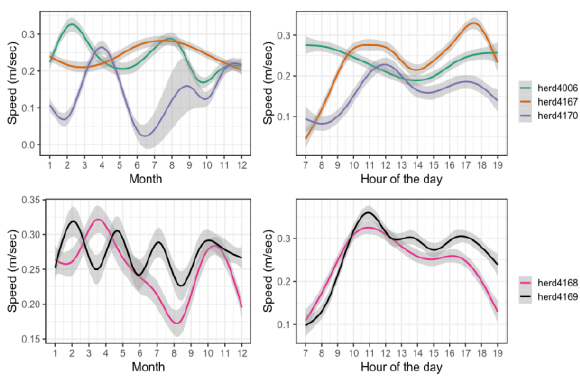
Figure 2: Monthly (A and B) and hourly (C and D) mean speed at which the herds moved on their landscape during the collaring period.